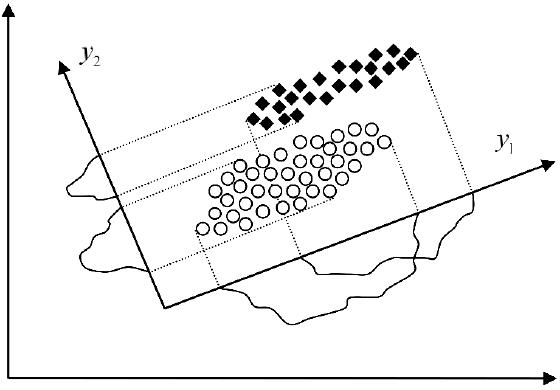
Figure 9. Dimension reduction in the feature space.